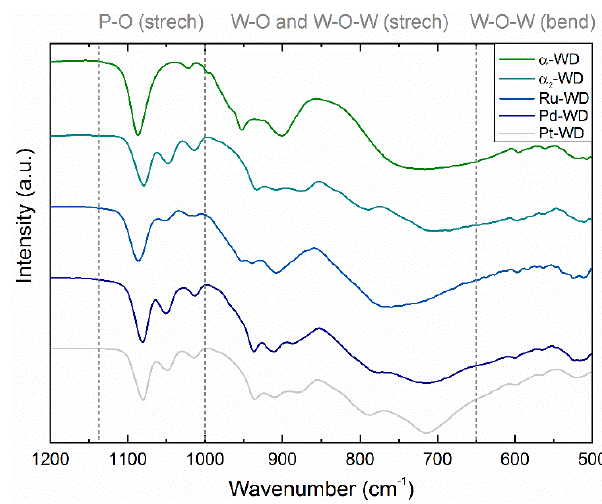
Figure 4. ATR-FTIR spectra of the prepared α -WD, α 2 -WD and metal-doped WDs in the range 1200 to 500 cm − 1 .